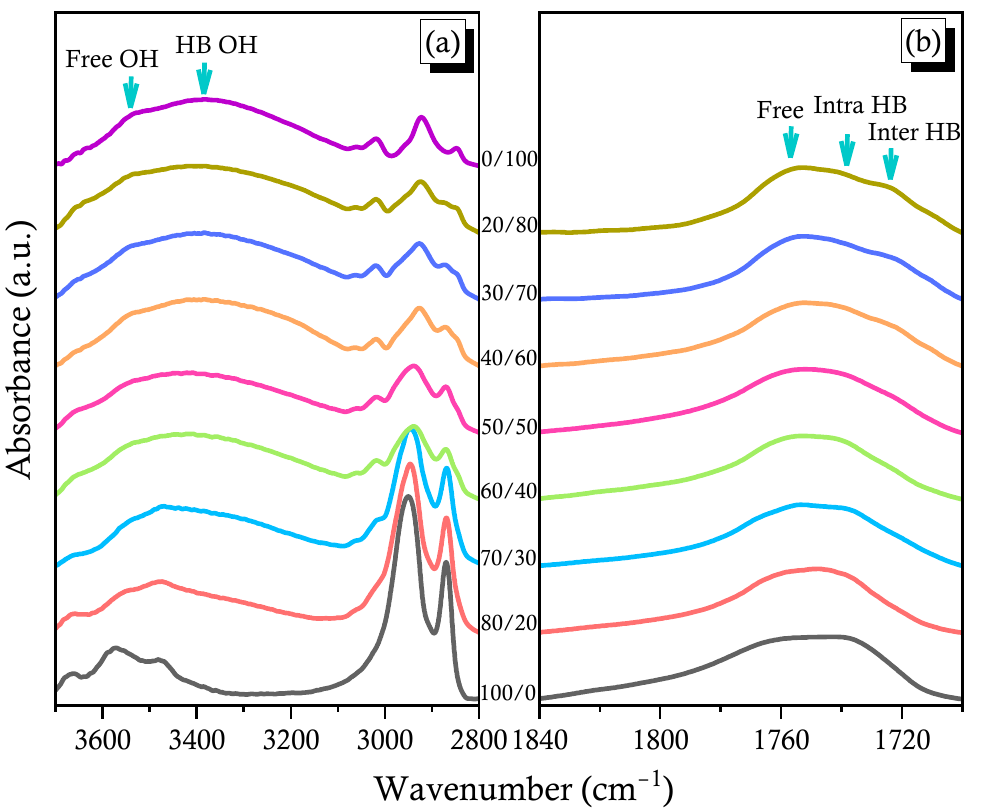
Figure 4. FTIR spectra of the various PVPh/PCHC binary blends, recorded at 120 °C: ( a ) OH and ( b ) C=O stretching regions.